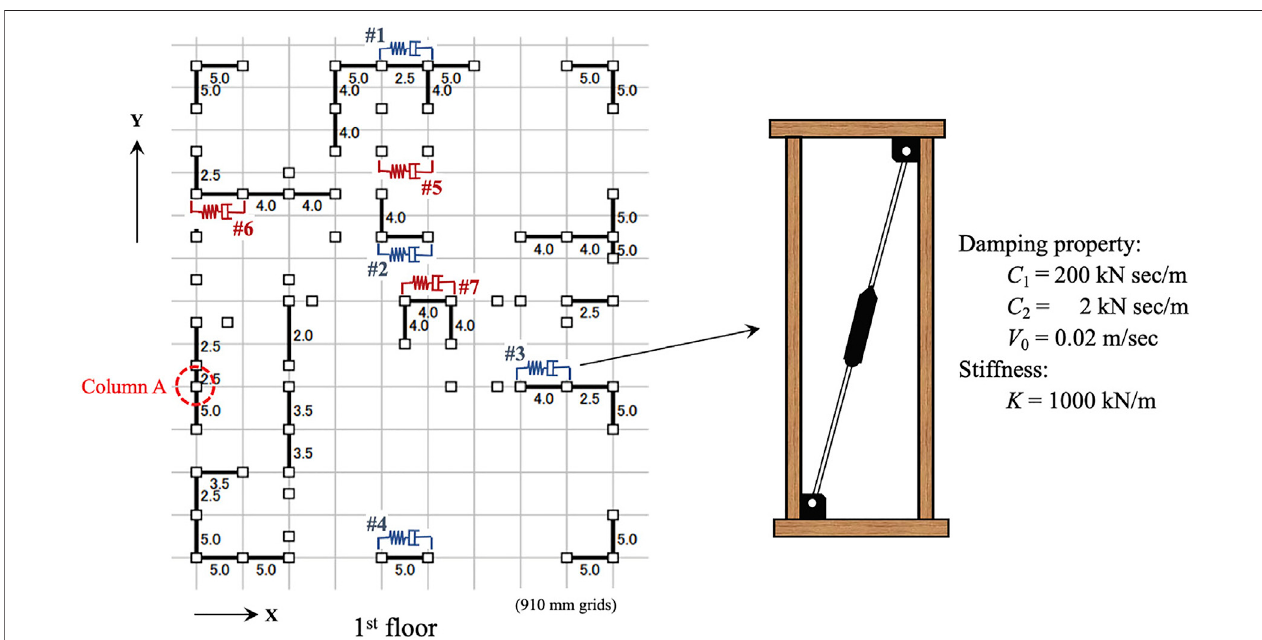
FIGURE 9 | Layout of small-size fl uid dampers in fi rst fl